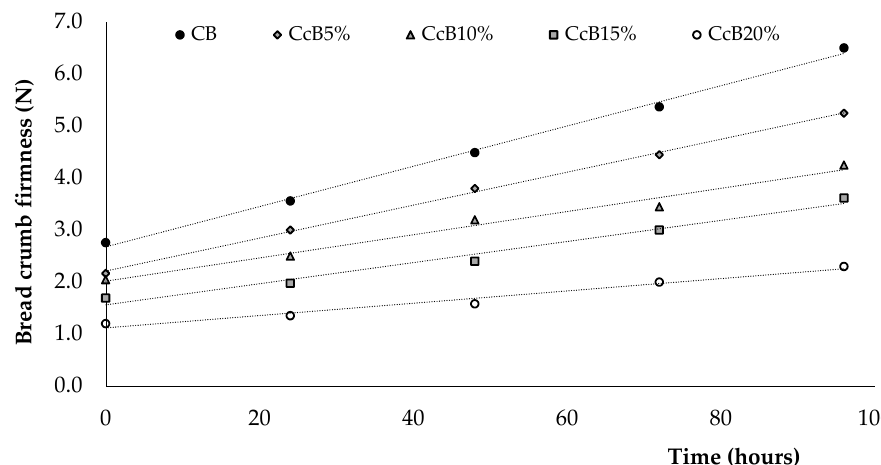
Figure 3. Evaluation of the gluten-free bread (GFB) crumb firmness progression, (96 h at room temperature), between control bread (CB) and curd cheese bread (CcB5% up to CcB20%). Initial and final values of BCF varied from 2.70 N to 6.50 N for CB and 1.12 N to 2.30 N for